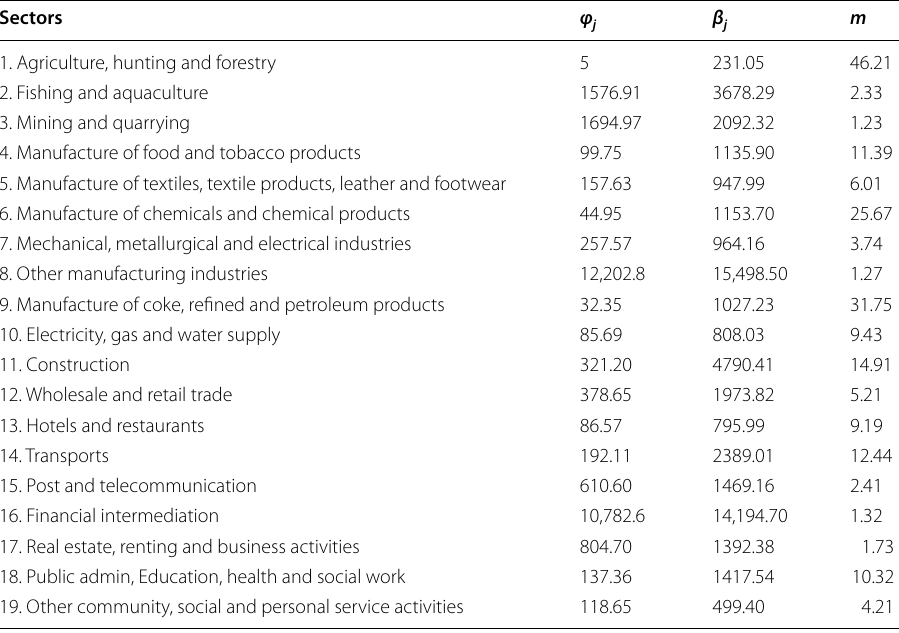
Table 4 Indicator of direct economic benefits of water use ( φ benefits of water use ( β ) and economic benefits of water use multiplier (m) j Sectors φ j β